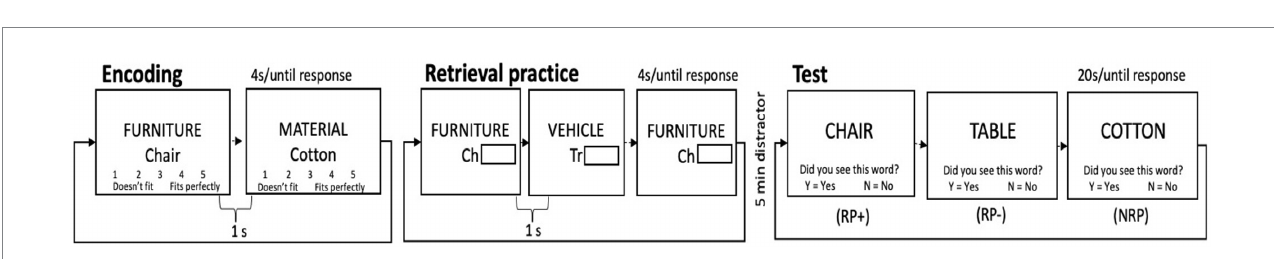
FIGURE 3 Schematic of the retrieval induced forgetting task. Shown here are two trials from the encoding phase, three trials from the retrieval practice phase, and three recognition probe trials. In this example, half of exemplars from the category ‘furniture’ were practiced, including ‘chair’ (and is hence an RP+ item), but not ‘table’, (and hence it is an RP-item). In this example, no items from the category ‘material’ received retrieval practice, and hence, all exemplars from this category (cotton, silk, burlap, etc…) are considered NRP